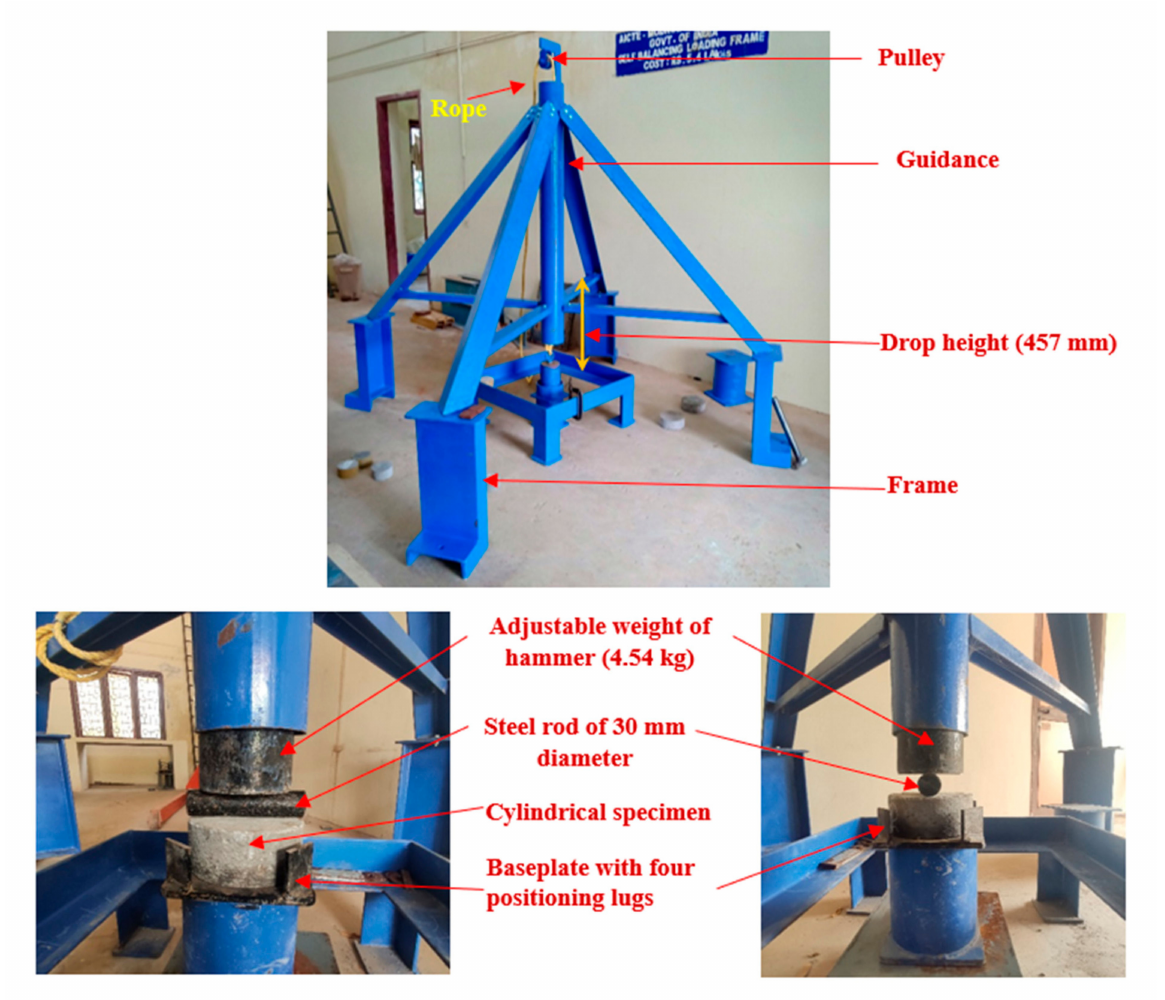
Figure 8. Device for measuring the impact of falling masses at low